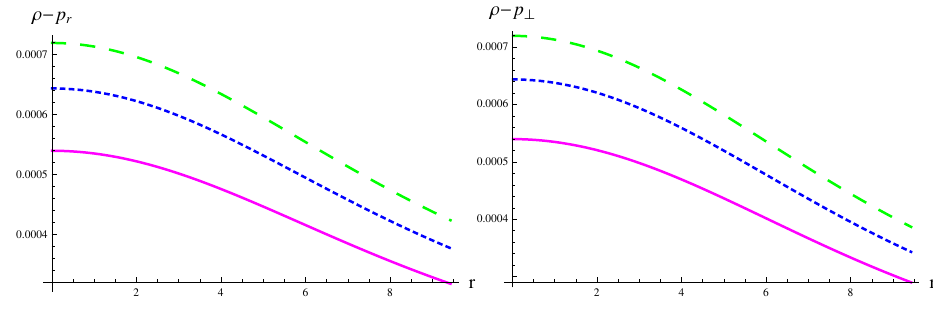
Figure 3. Behavior of ρ , p r , p ⊥ (in km − 2 ) and ∆ of solution I for Υ = 0.9.